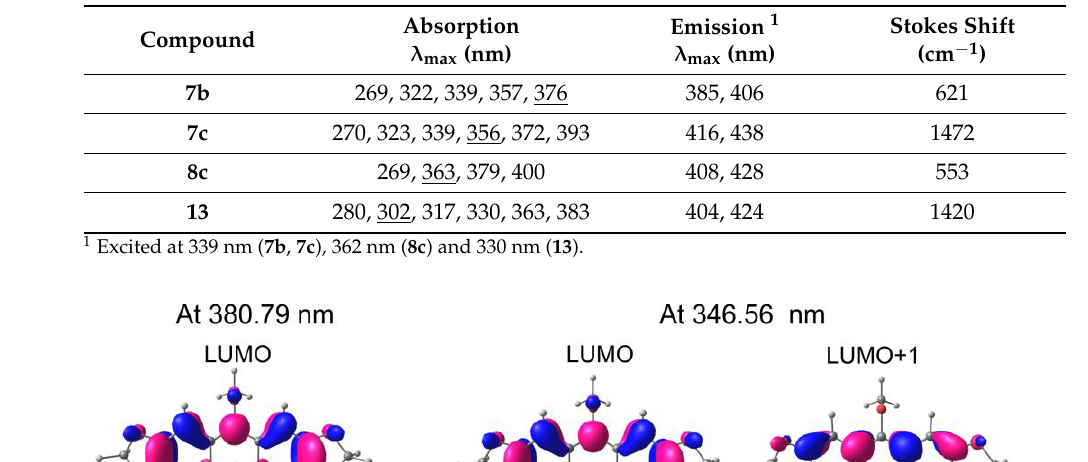
Table 2. Absorption and emission maxima ( λ max ), Stokes shifts in dichloromethane solution (10 − 5 mol/dm 3 , 25 ◦ C) for 7b,c , 8c and 13 (underlined values are highest absorption maxima in the lower part of the spectrum in the 300–420 nm range).